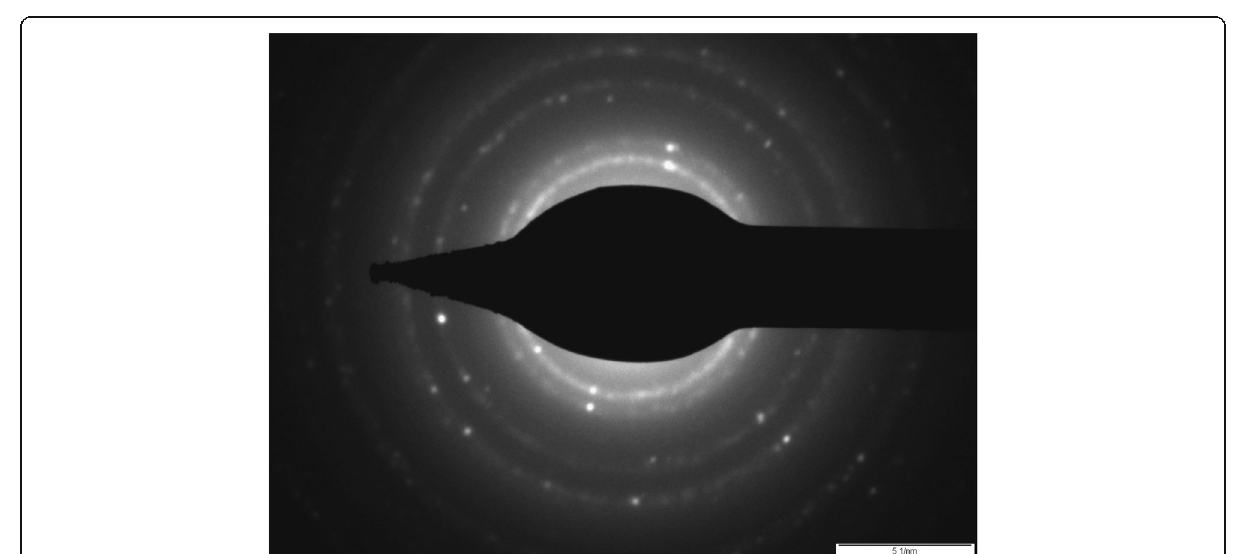
Fig. 7 SAED pattern of the